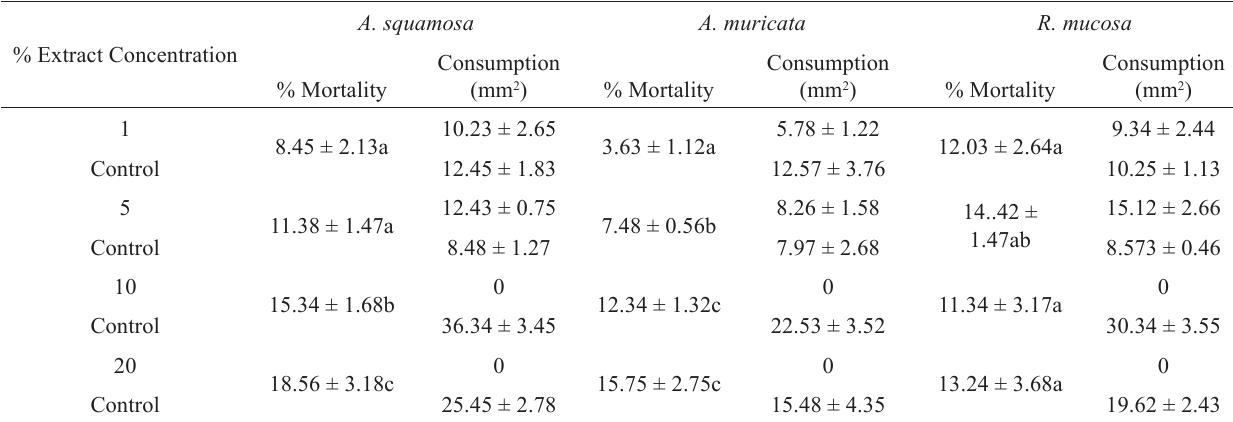
Table 1 . Average mortality and paper consumption of C. gestroi in choice feeding test with filter paper treated with various concentration of Annona seed extract.